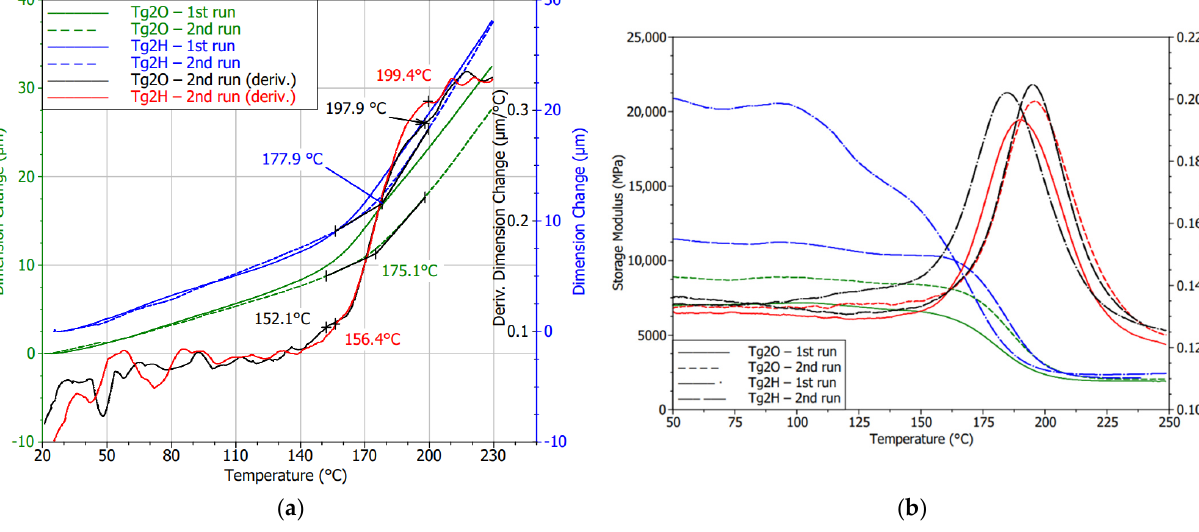
measurement run. Further, the curve bend was not as striking as it was typical for the previous laminates. Hence, inaccuracy in Tg determination may occur. Regardless of this fact, the Tg was almost independent on the surface finish, and the values increased by undergoing the thermal treatment under the conditions of the TMA measurements as can be seen in Figure 15. The Tg for Tg3H was detected to be higher by 3.5% on average, which can be found to be relatively insignificant. However, noticeably lower values than those declared in the datasheet must be considered for a potential application.